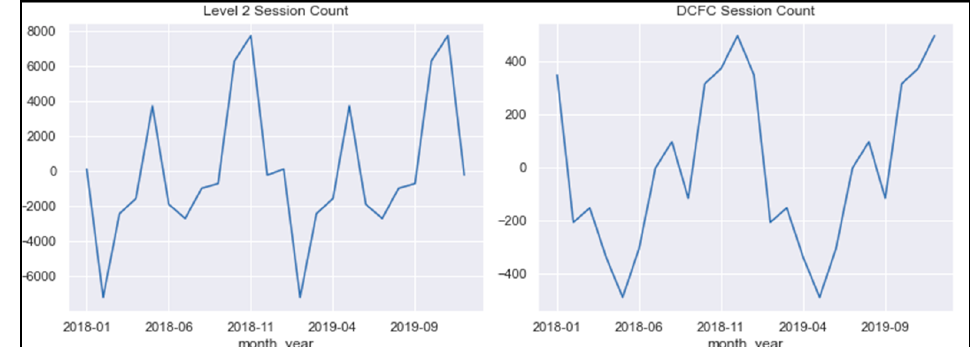
Figure 10. Seasonality in charging demand for Level 2 and